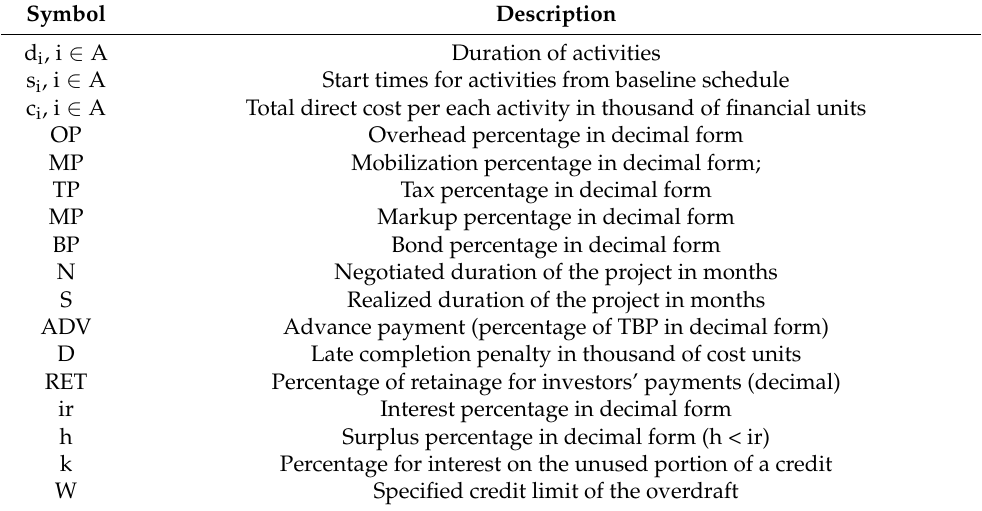
Table 4. Input variables required for financial flow